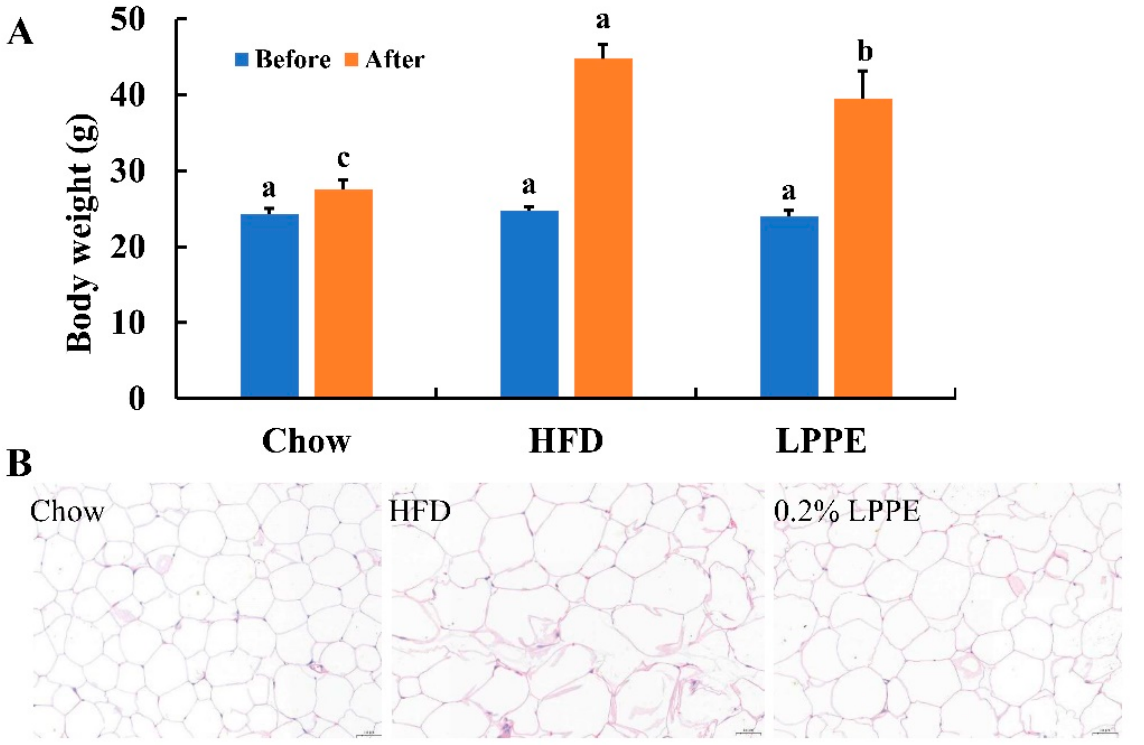
Figure 2. Effects of LPPE on the body weight and the cell size of epididymal adipose tissues in high-fat diet-induced-obese mice. ( A ) Body weight. ( B ) H&E staining ( × 200) of the epididymal adipose tissues. Values are expressed as the mean ± SEM (n = 8). Different letters above the bars with the same color indicate significant differences ( p < 0.05).